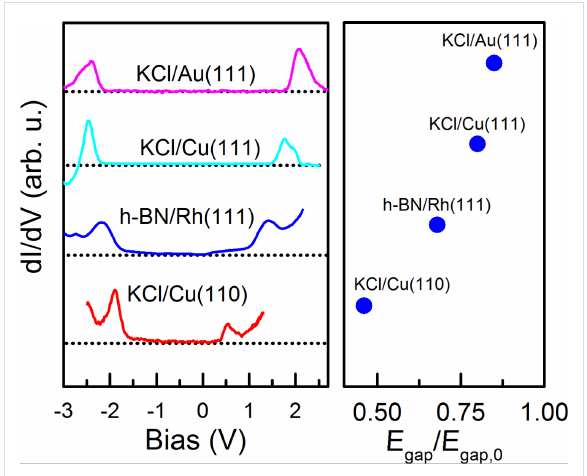
Figure 7: STS measurements of pentacene on various decoupling layers (see legend). In the case of Au(111) and Cu(111), KCl grows as a bilayer, whereas on Cu(110), a monolayer growth was observed. The right graph indicates the deviation of the HOMO–LUMO gap of pentacene on the respective surfaces ( E gap ) from its unperturbed gas- phase gap ( E gap,0 ).